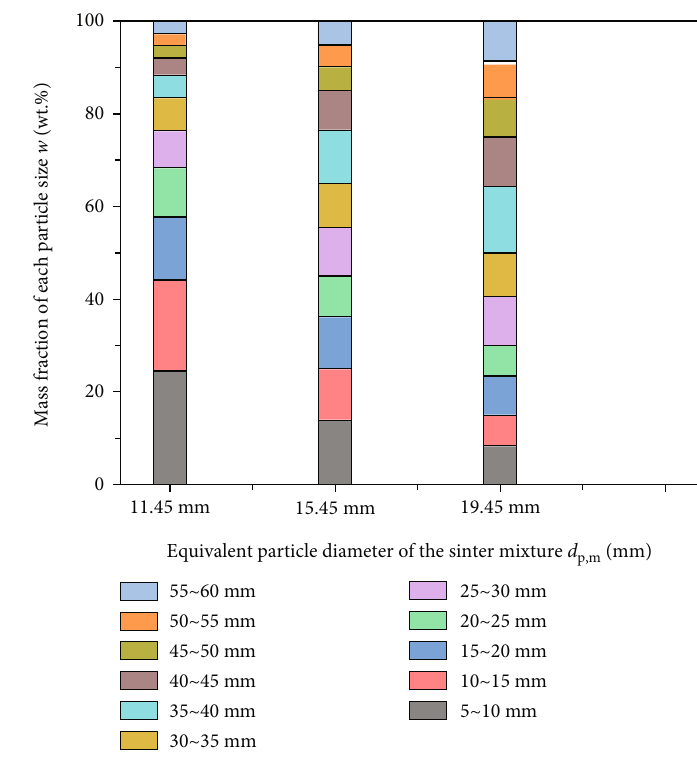
Figure 5: The particle size distribution of the three types of sinter